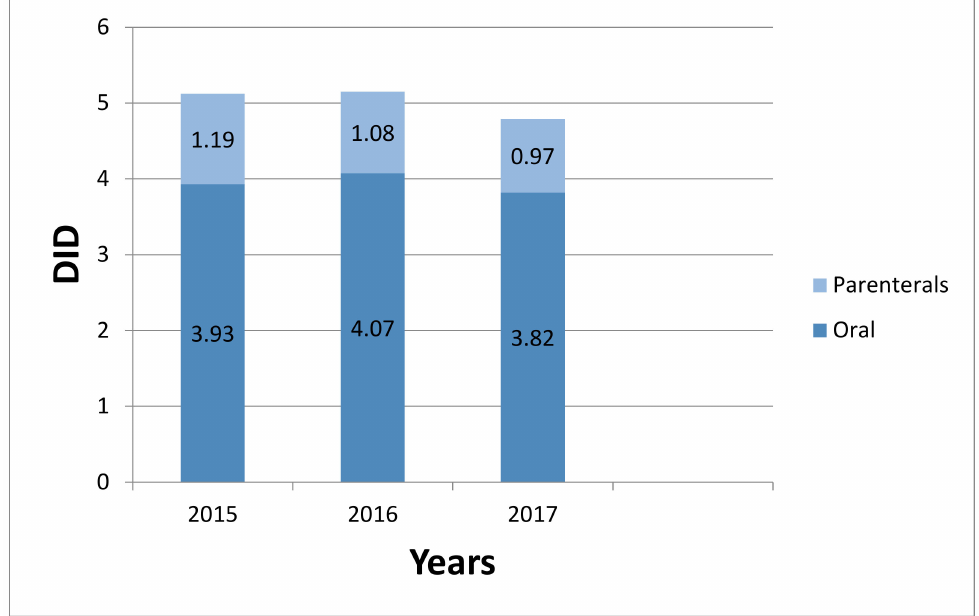
Figure 2. Consumption of oral and parenteral antibiotics in China,